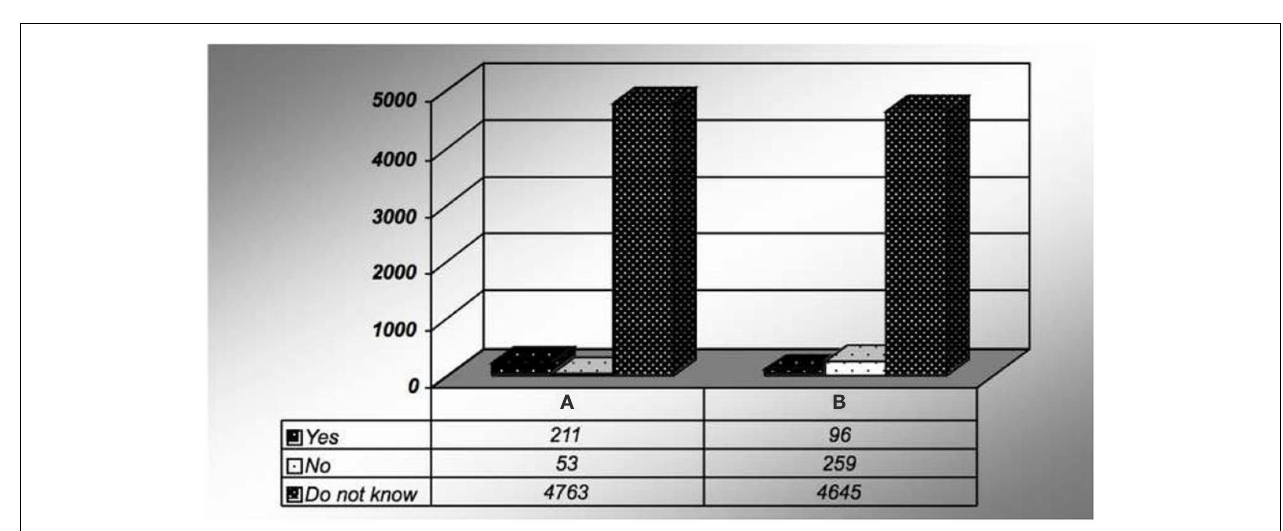
FIGURE 3 | Survey response for (A) fatty liver is preventable . And (B) do you think fat in the liver can cause a serious health